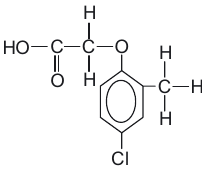
Figure 1. Molecular Structure of